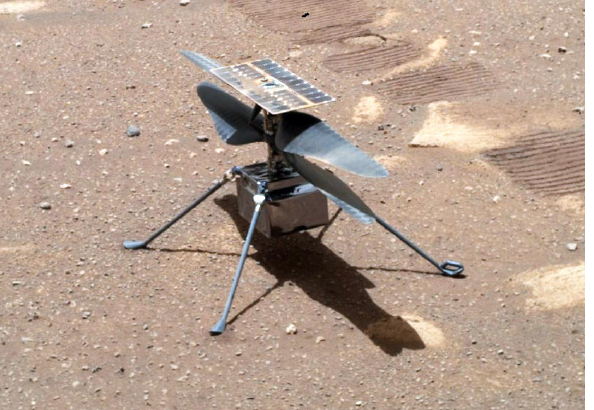
Figure 8. Image of the Ingenuity helicopter on Mars acquired on 7 April 2021 (Sol 46). IMM multi-junction solar cells are clearly visible from its top